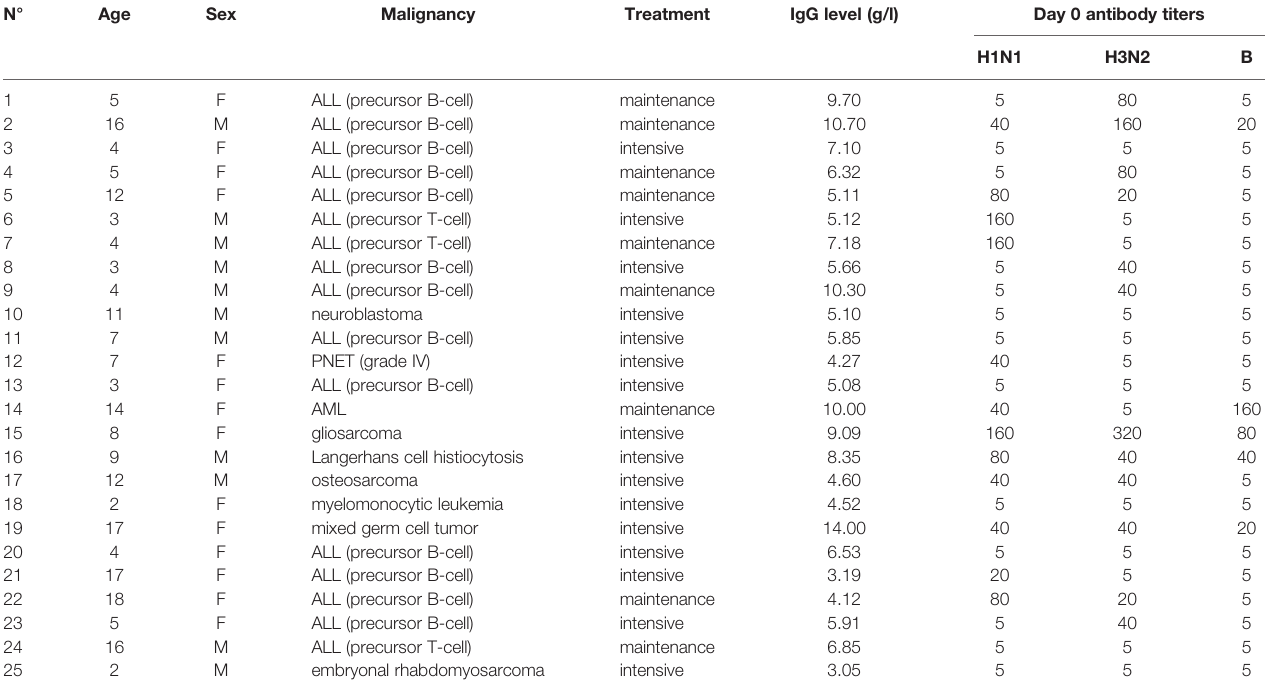
TABLE 1 | Patient